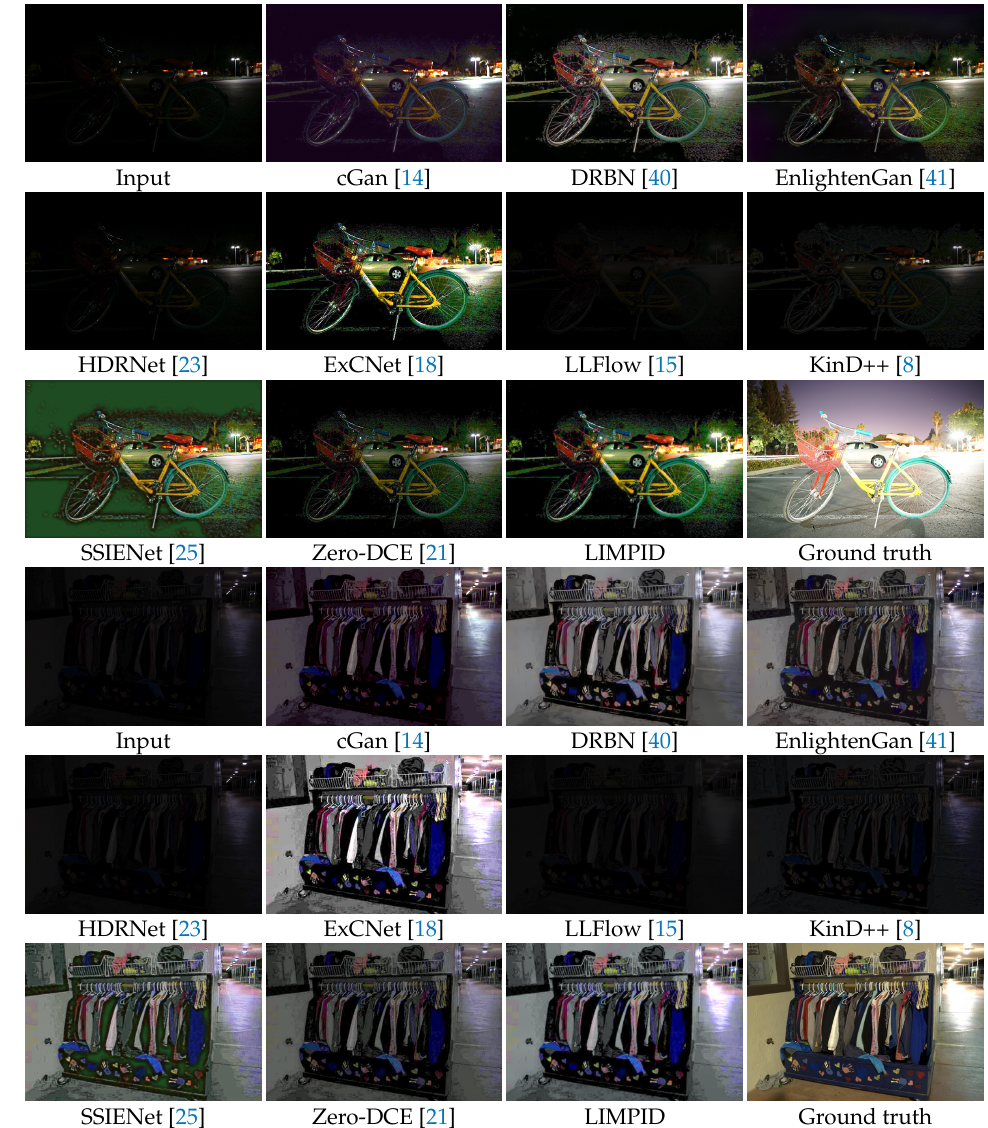
Figure 6. Results on the SID dataset of LIMPID and existing SOTA methods in